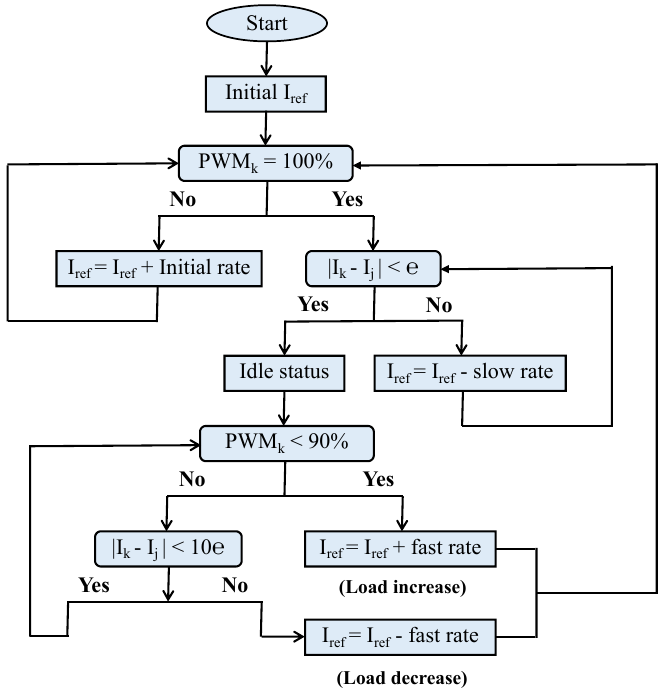
Figure 6. Flowchart of the autonomous closed-loop control algorithm